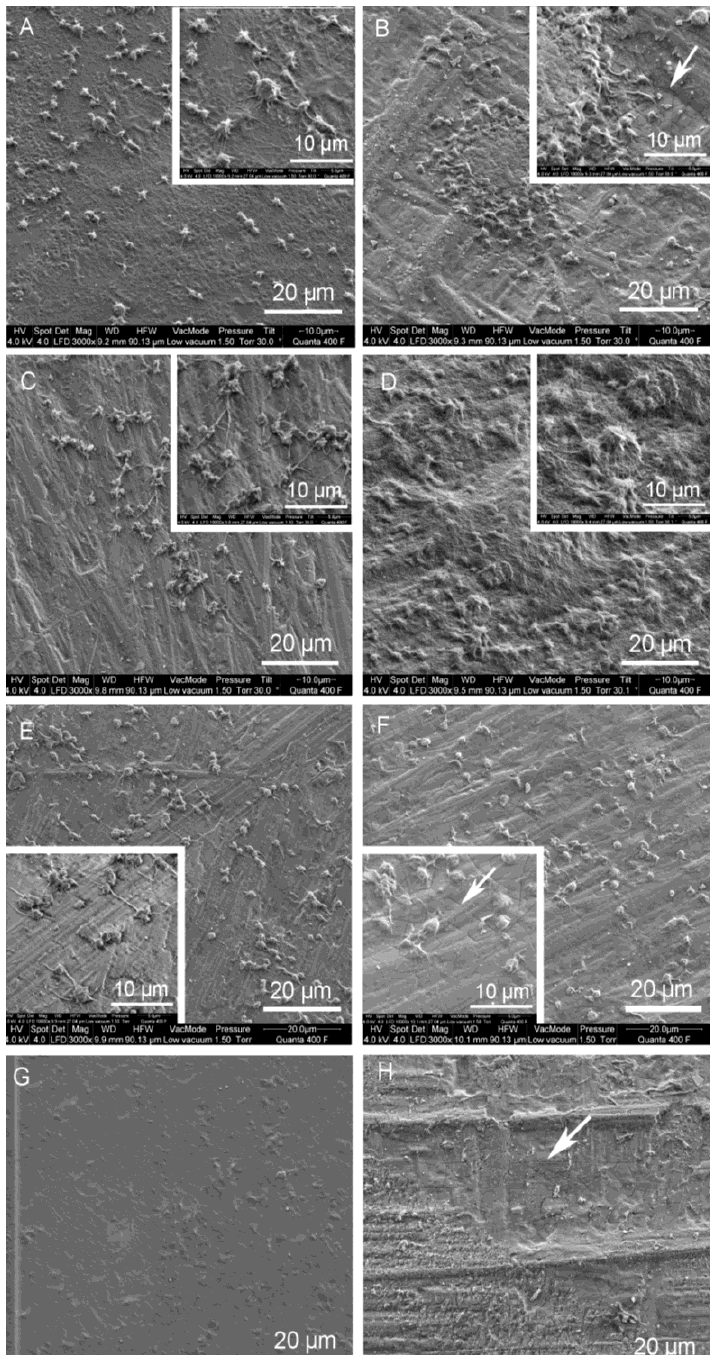
Figure 5. Morphologies of adherent platelets on the surface of different PUs. Isolated platelets were incubated with pure and titaniferous upgrading PUs. Representative SEM photographs of adherent platelets (3000× magnification) on ( A ) PU_1; ( B ) ti_PU_1; ( C ) PU_2; ( D ) ti_PU_2; ( E ) PU_3; ( F ) ti_PU_3 presented different cell density on the surface of the test samples; ( G ) PU_4 and ( H ) ti_PU_4 were more or less free of platelets. Arrows indicate small cracks in the titaniferous